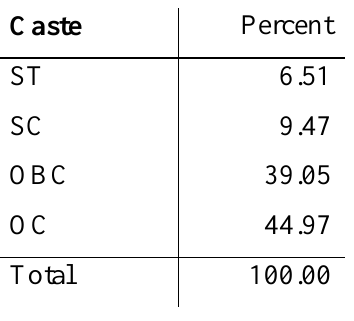
Table A2.3 Caste Distribution of Sample